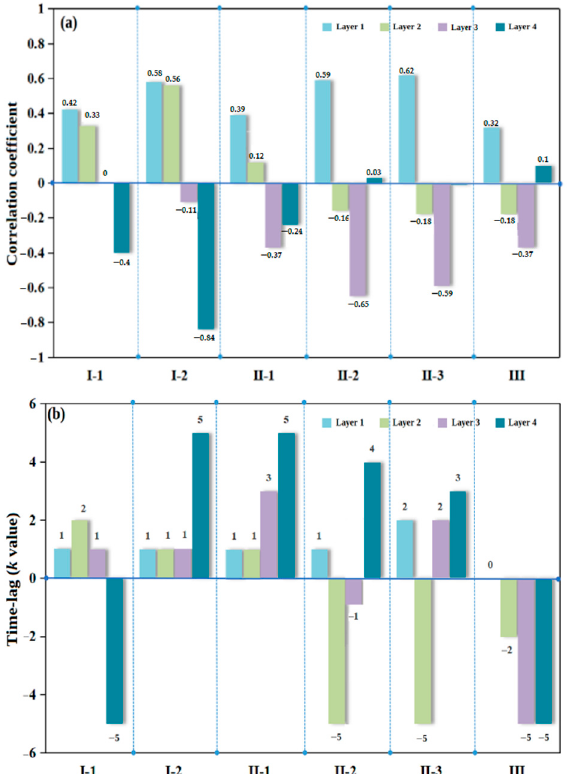
Figure 6. Extremum correlation coefficient ( a ) and lag time ( b ) between the NDVI and soil moisture at various depths for different vegetation types.